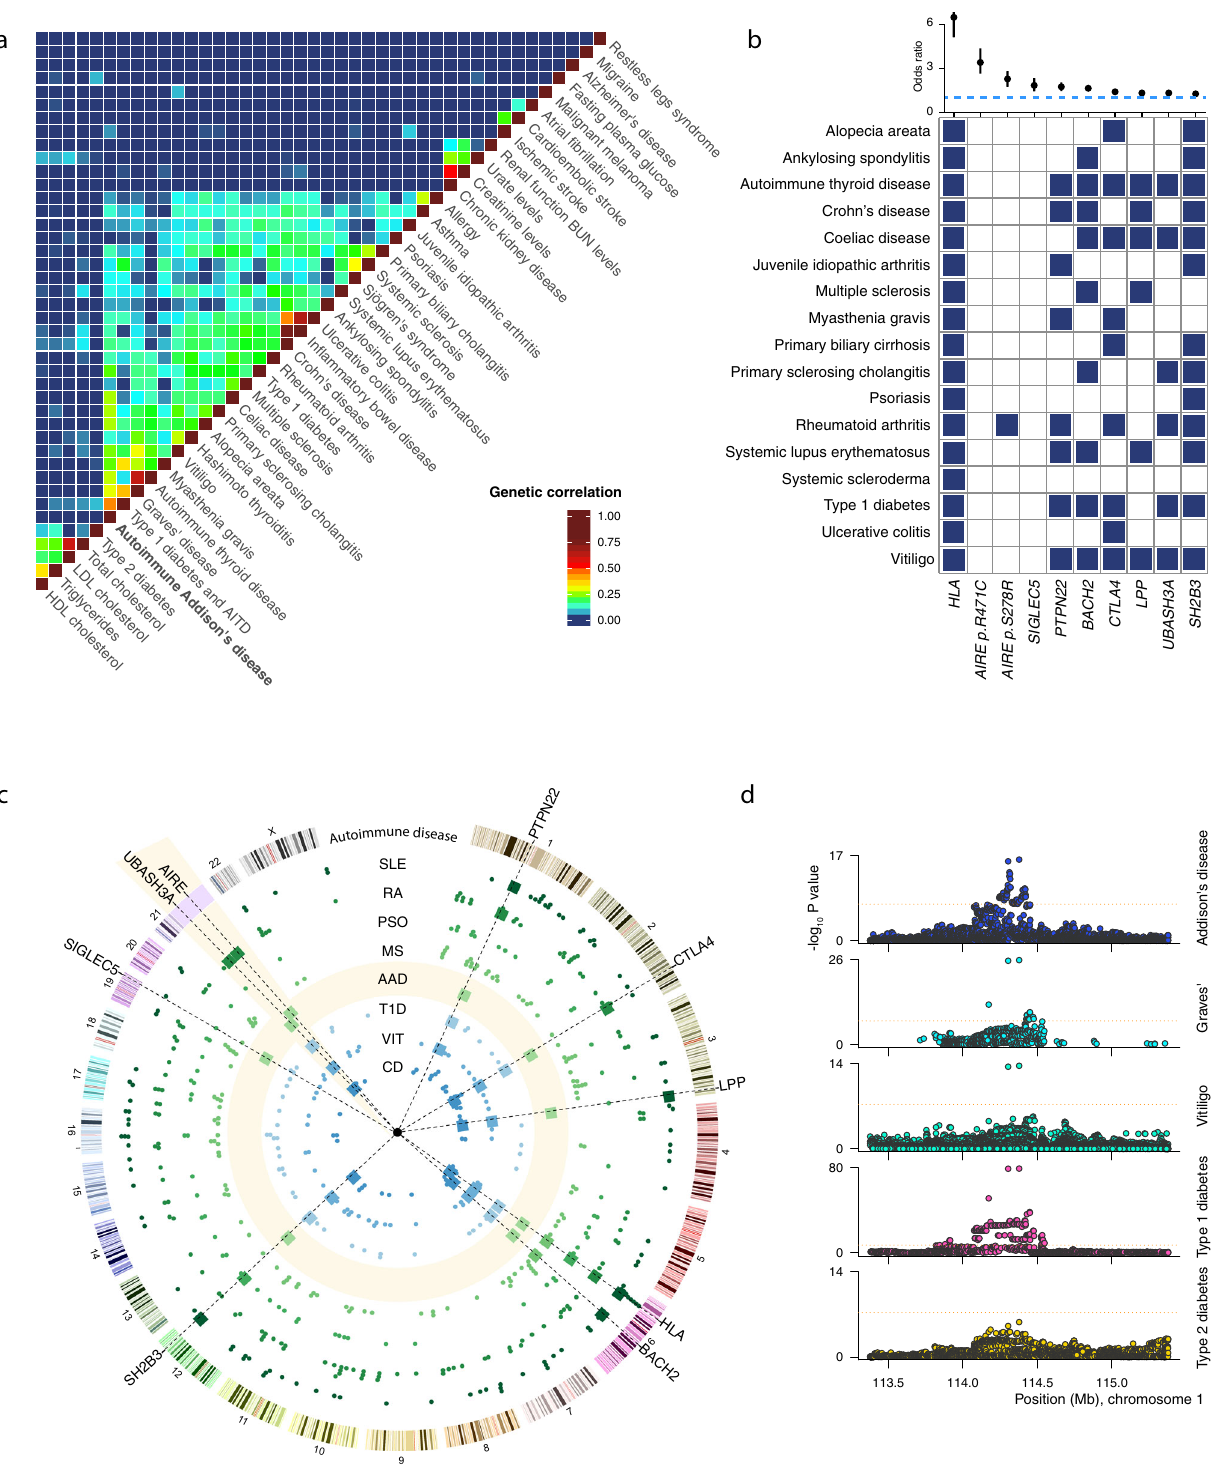
Fig. 5 Shared genetic features. a Human diseases and traits studied in GWAS were clustered to reveal shared genetic risk factors. Diseases/traits are ordered by unsupervised hierarchical clustering, and color scale indicates genetic correlation. b Loci implicated in autoimmune Addison ’ s disease in order of decreasing effect size (odds ratio and 95% CI), 1223 cases, and 4097 controls. The horizontal, dashed line marks OR = 1. Blue squares indicate genome- wide signi fi cant associations for the diseases and loci/variants, respectively. c Circos plot representing the loci associated with AAD (boxes) and other autoimmune diseases (dots). The AAD track is highlighted in yellow, and the yellow wedge on chromosome 21 is magni fi ed ×15. SLE-systemic lupus erythematosus, RA-rheumatoid arthritis, PSO-psoriasis, MS-multiple sclerosis, T1D-type 1 diabetes, VIT-vitiligo, CD-coeliac disease. d Side-by-side comparison of association statistics at the PTPN22 locus across a selection of autoimmune diseases. AAD statistics were calculated using logistic regression for 1223 cases and 4097